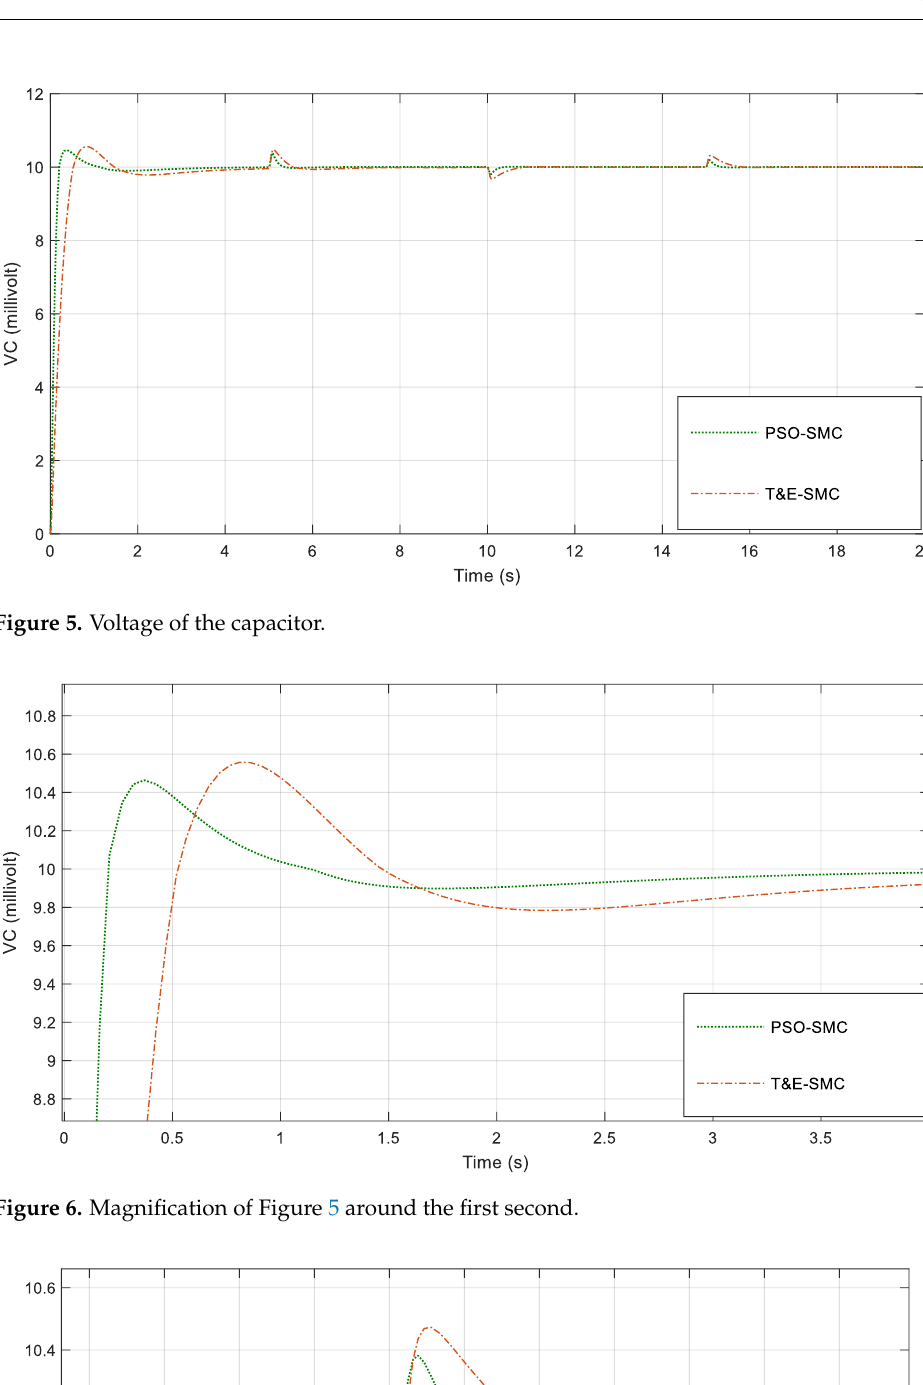
Figure 8. Magnification of Figure 5 around the tenth second. Figure 9. Magnification of Figure 5 around the 15th second.